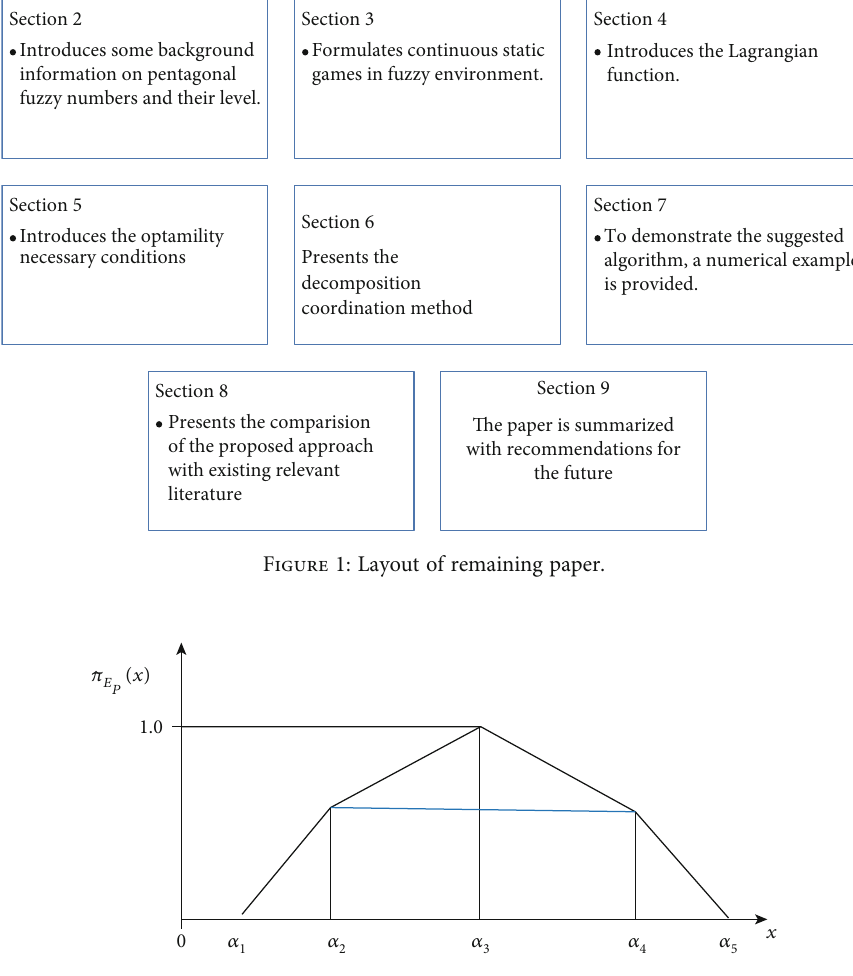
Figure 2: Depiction of a PFN [29].